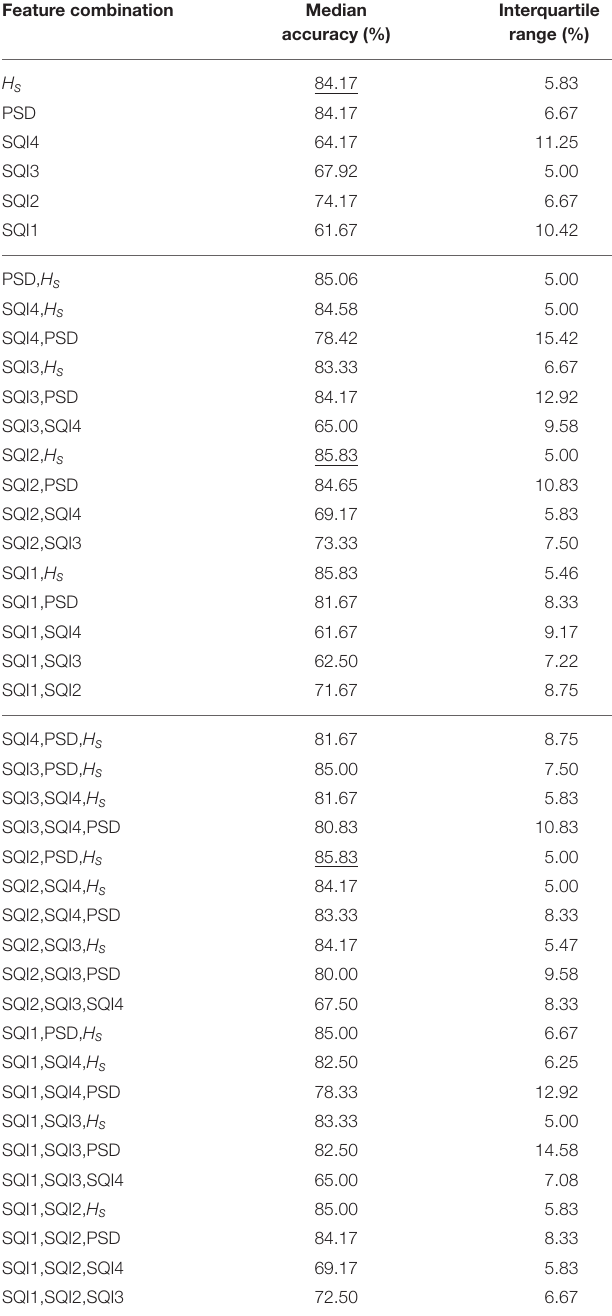
TABLE A1 | Median classification performance of the 100 five-fold cross validation balanced with bootstrapping for all the possible feature combinations.